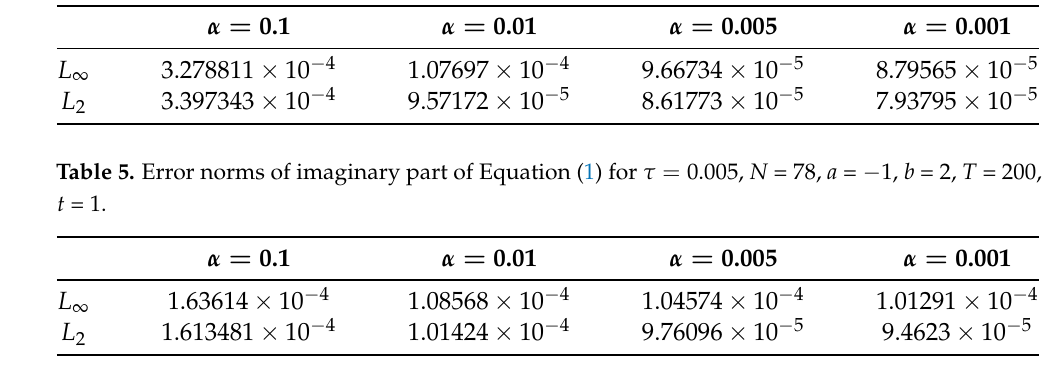
1, b = 2, T = 200, t = 1. −